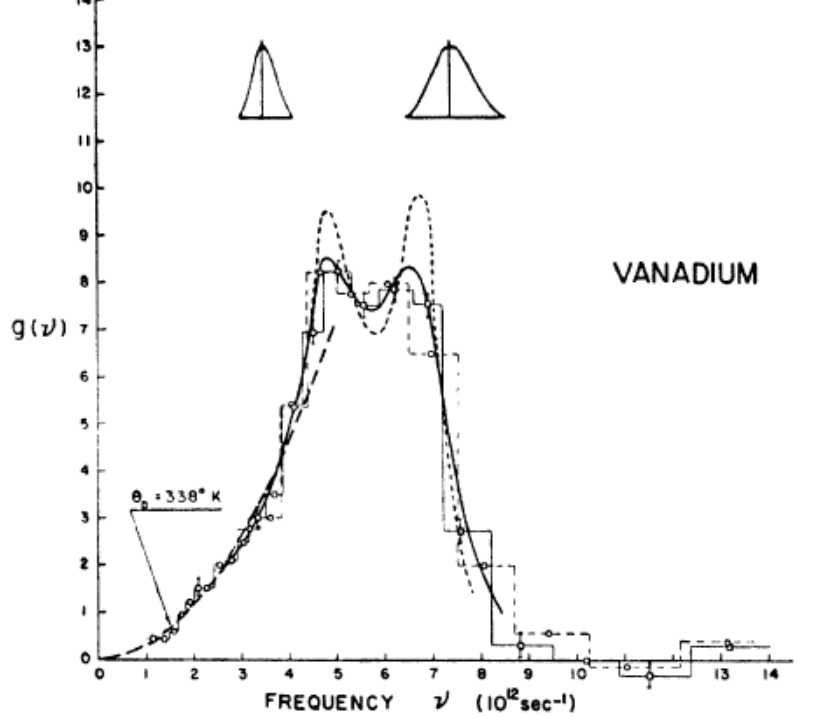
Figure 10. The vibrational spectrum, g ( ν ), of vanadium with the instrumental energy resolution shown as Gaussian curves. The full line is drawn through the combined histograms. The light dashed curve shows a possible spectrum with the resolution removed. The heavy dashed line at low frequencies shows part of the Debye spectrum for a Debye temperature θ D = 338 ◦ K as determined by low-temperature specific heat measurements. This figure is taken from Figure 6 of ref. [35]. Copyright by the American Physical Society.